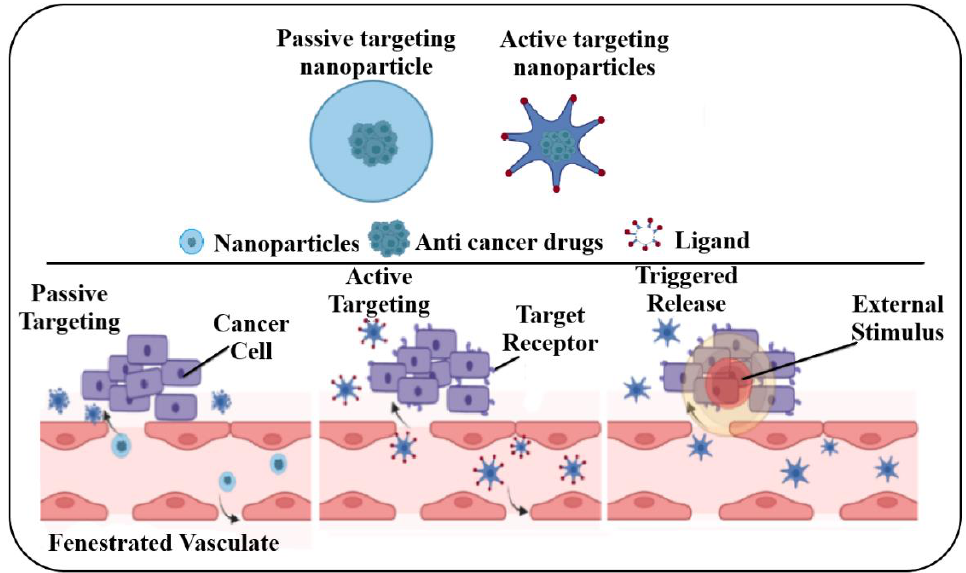
Figure 4. Action mechanism of passive and active targeting.